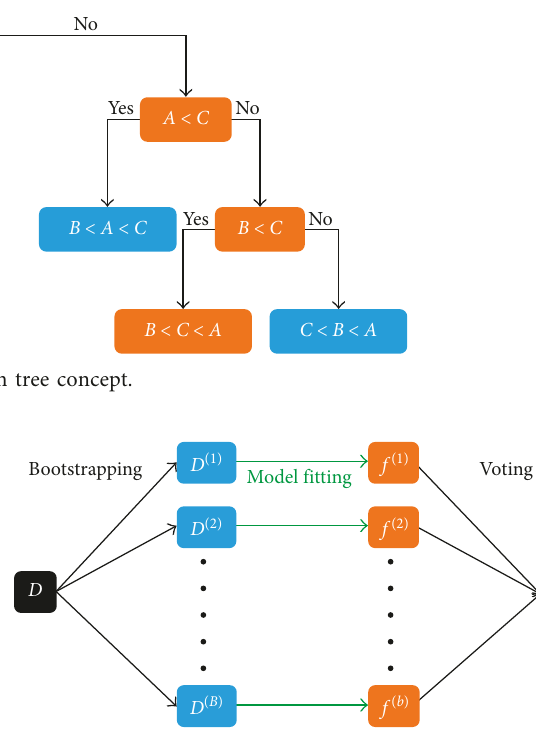
Figure 2: Bagging concept.